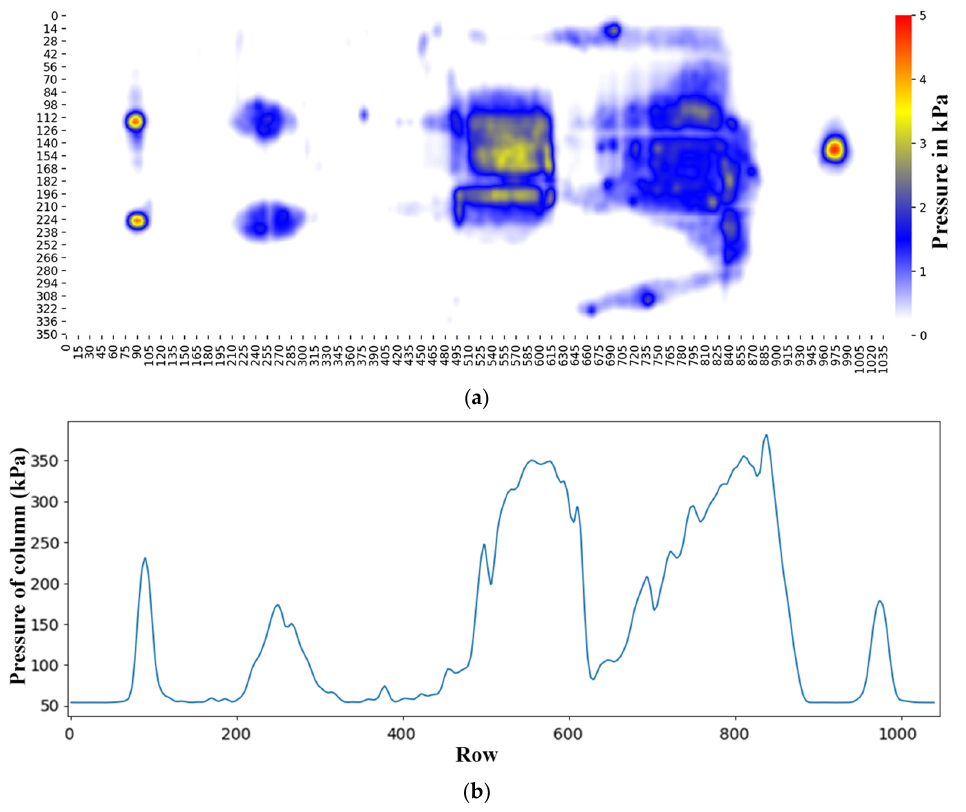
Figure 9. Pressure distribution of people lying down: ( a ) Pressure area; ( b ) Summation of column. Table 1. Pressure between people of different